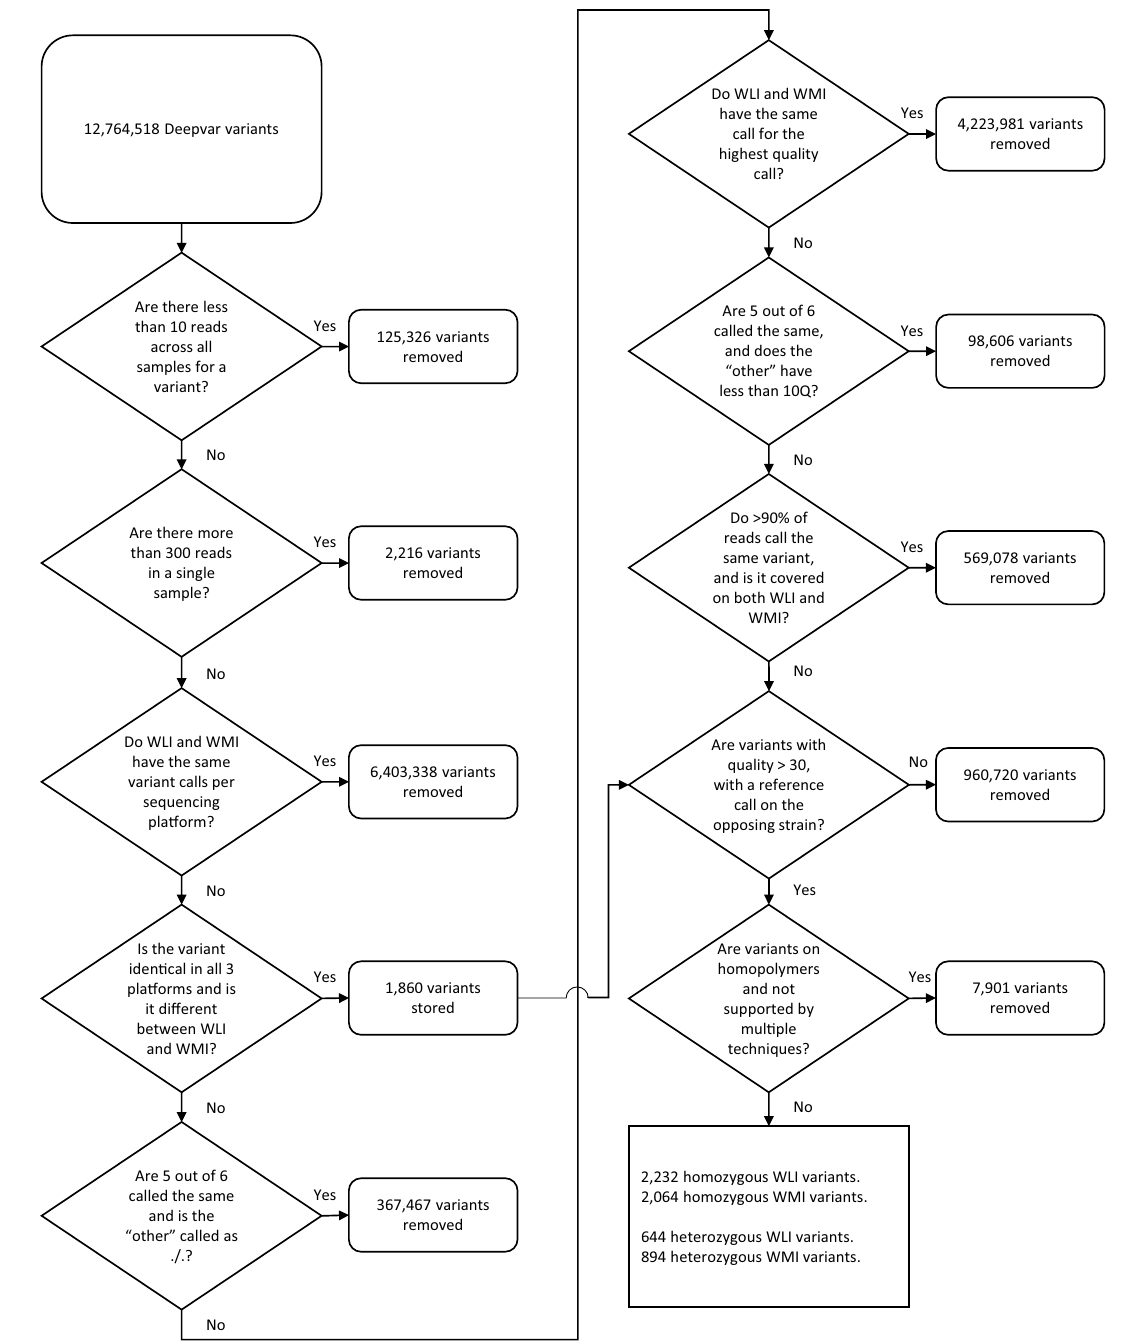
Figure 1. Flowchart of each filtering step and the number of variants removed per step. The initial 8 steps were performed in Python, the last 2 were performed in